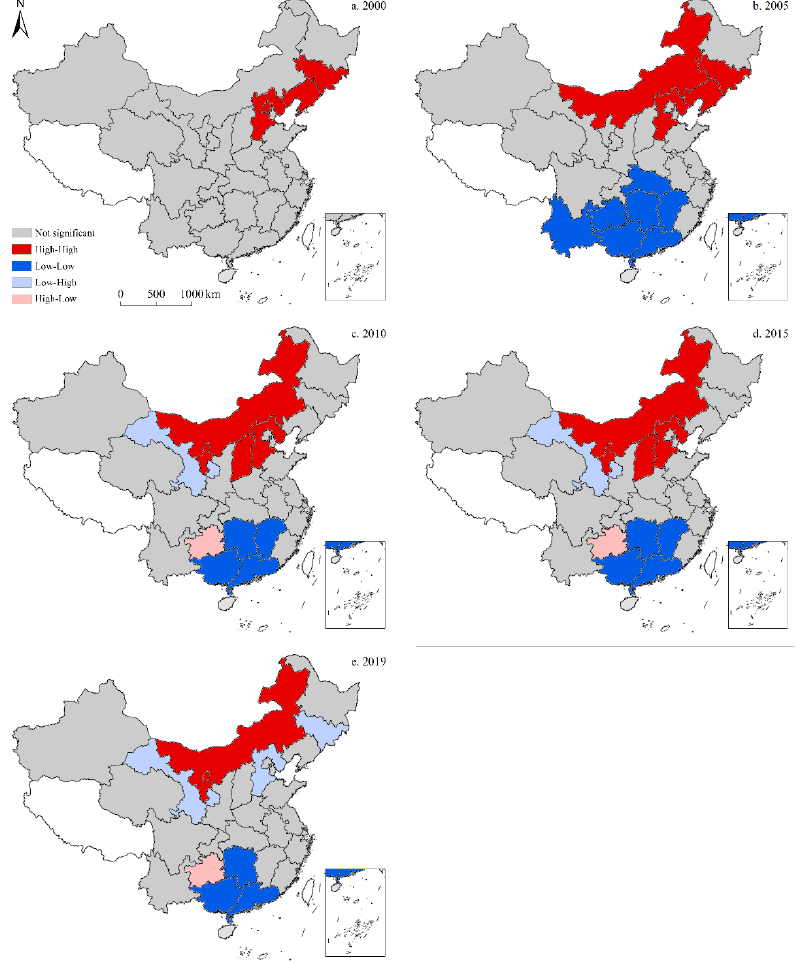
Figure 11. LISA map for the provincial-level spatiotemporal distribution of CO 2 emissions per capita in China (five-time sections).